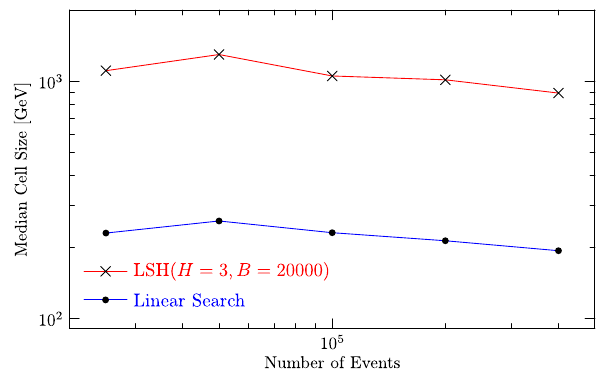
Fig. 4 Comparison of the median cell size between linear nearest- neighboursearchandtheLSH-basedapproachwiththreehashfunctions